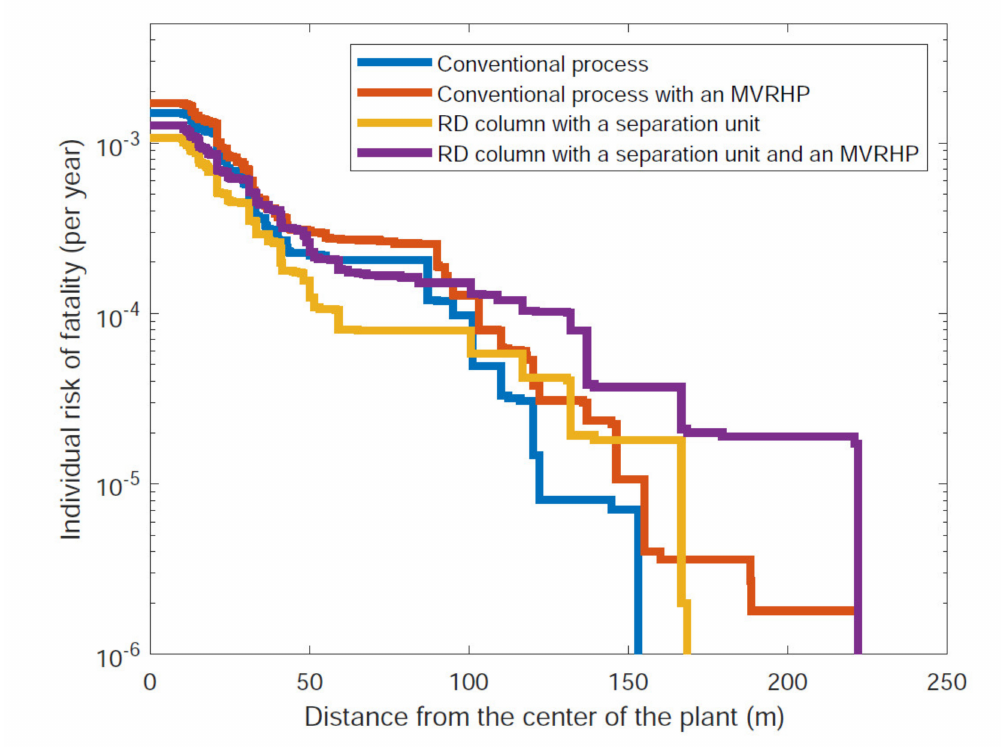
Figure 10. Individual risk of fatality estimation for presented case